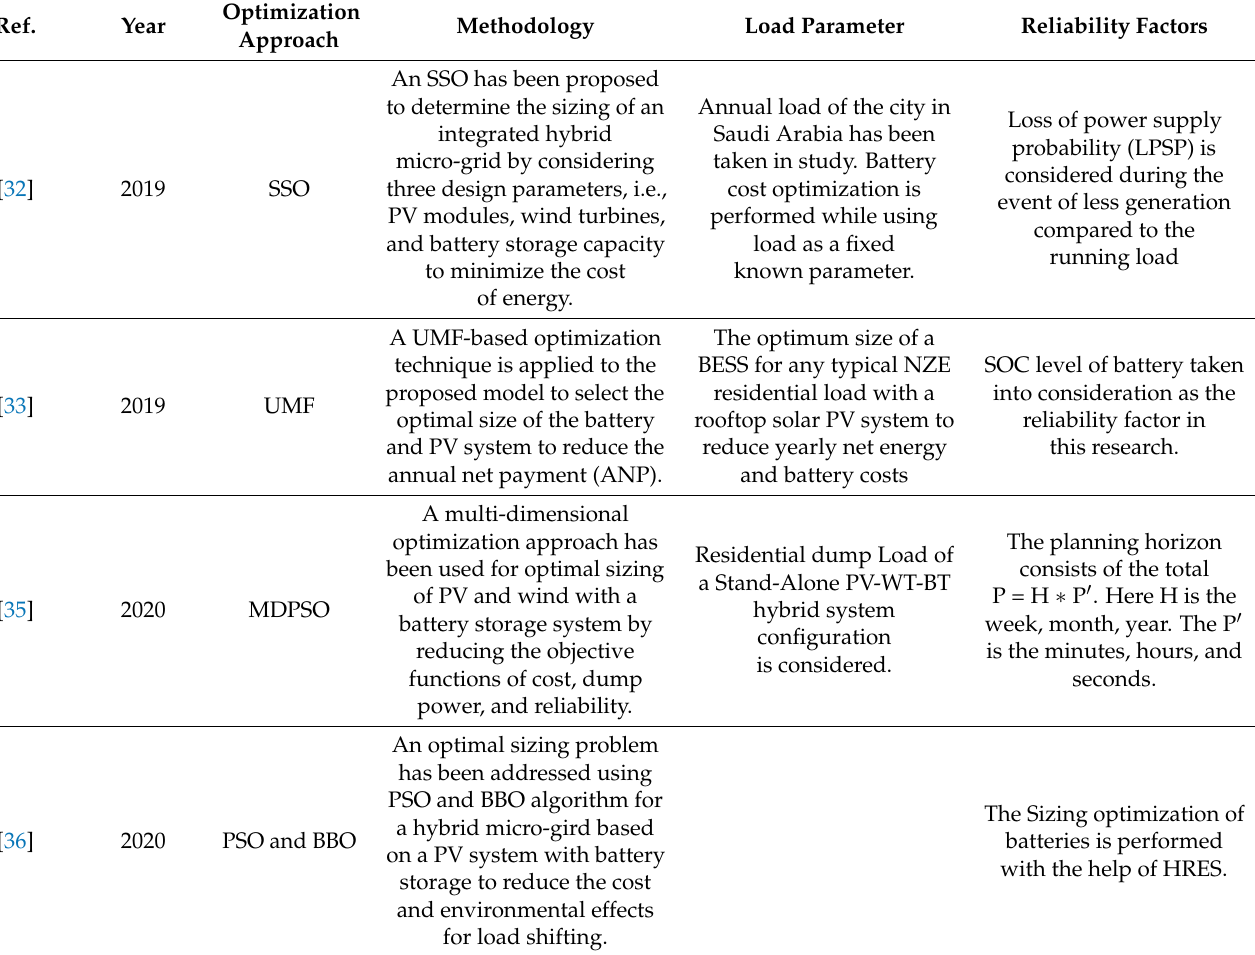
Table 1. Optimization methodologies are compared for different parameters here.